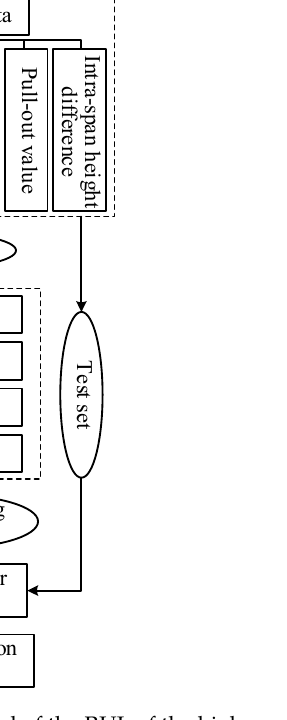
Figure 7. The final model of the RUL of the high ‐ speed rail catenary under the stacking